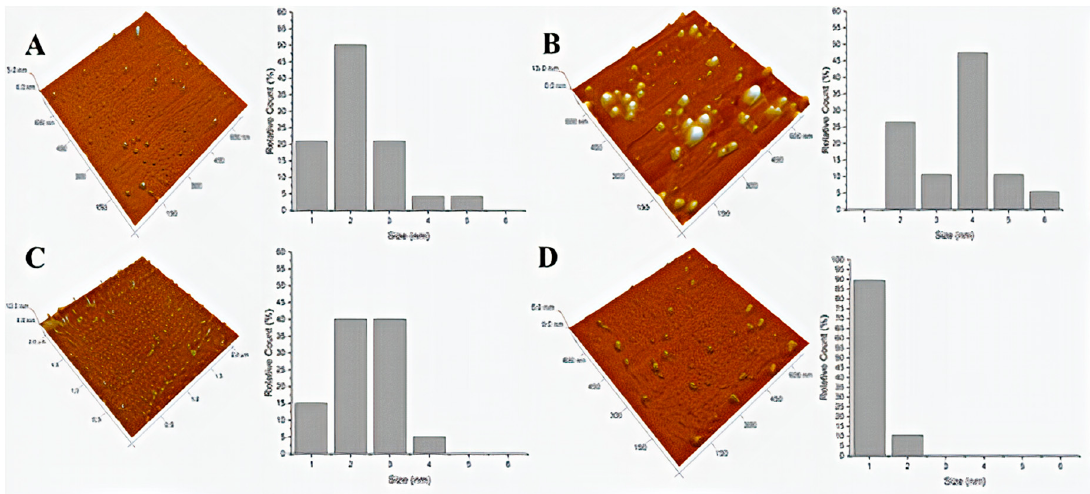
Figure 1. Atomic force microscopy (AFM) images and relative size distribution for ( A ) decaf-CDs, ( B ) rossio-CDs, ( C ) prestige-CDs and ( D ) CA@U-CDs.